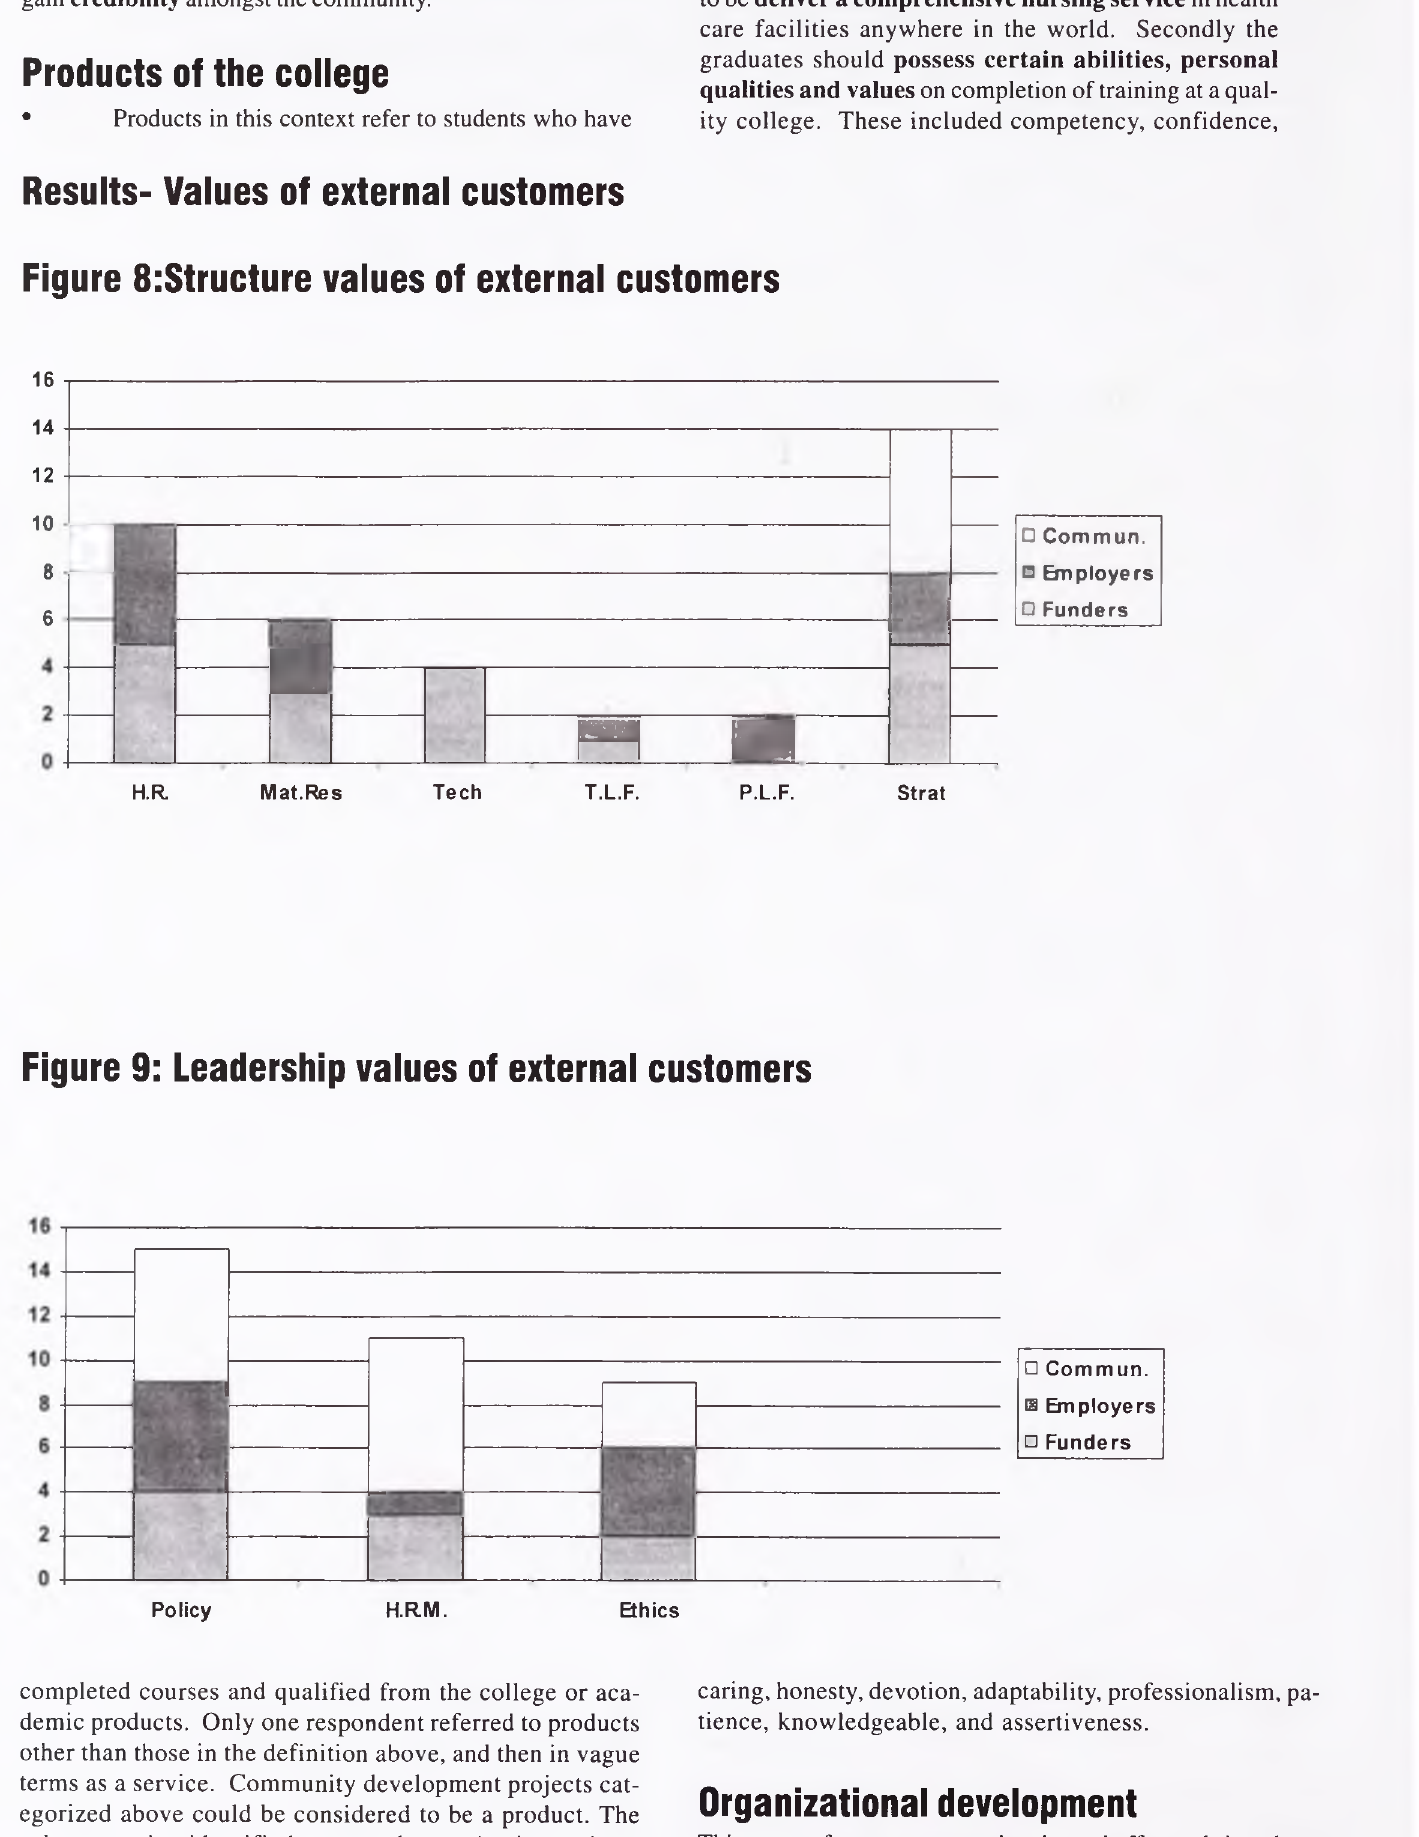
Figure 8:Structure values of external customers